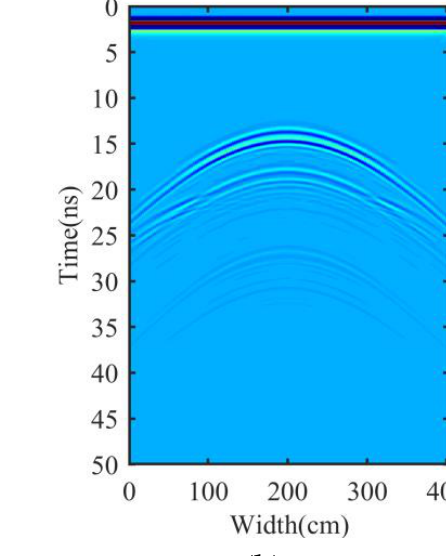
Figure 10. GPR B-scan image of a disease model with an irregular cavity above pipeline: ( a ) Ob- tained by non-conformal method; ( b ) Obtained by the conformal method.